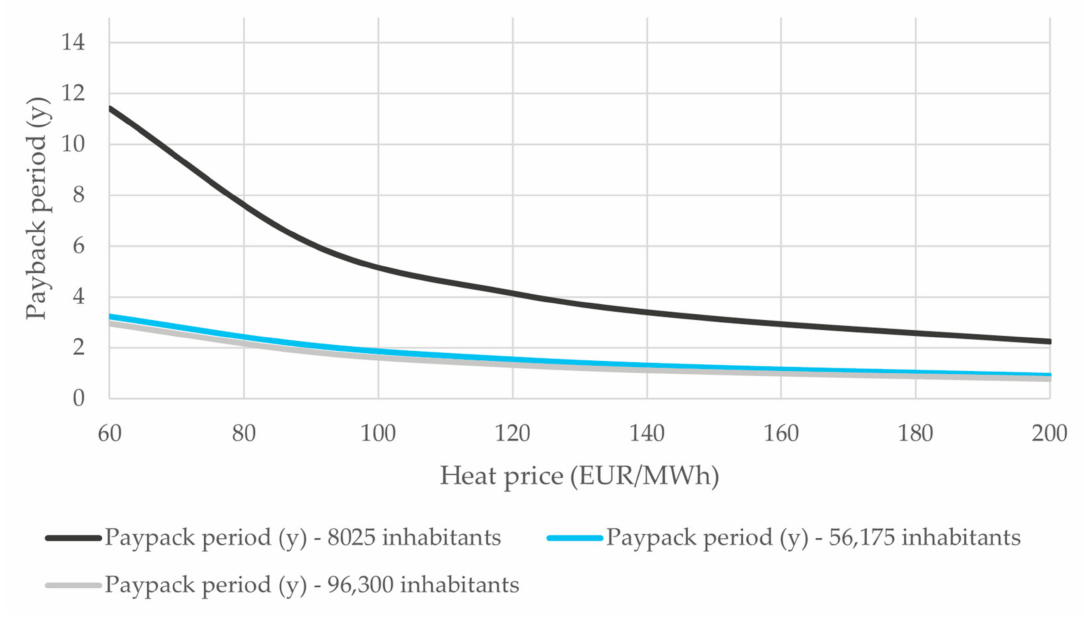
Figure 8. The payback period for different prices of heat from natural gas.